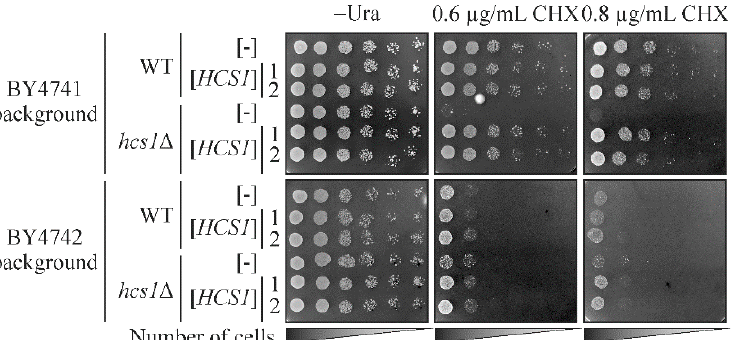
Figure 2. The hcs1 Δ strain is hypersensitive to cycloheximide. The wild-type (WT) and hcs1 Δ strains in the BY4741 or BY4742 backgrounds transformed with empty vector ([-]) or plasmid bearing the HCS1 gene ([ HCS1 ]) were grown overnight in SC-ura medium, serially diluted and spotted on SC-ura medium supplemented with cycloheximide (CHX) as indicated. Two independent transformants bearing the HCS1 gene were tested. The plates were incubated for 6 days at 28 ◦